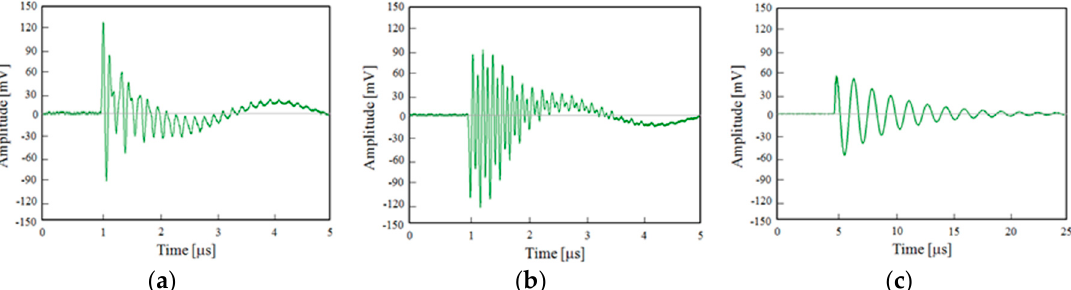
Figure 13. PD pulse of ( a ) internal, ( b ) surface, and ( c ) corona discharges acquired with the HFCT.